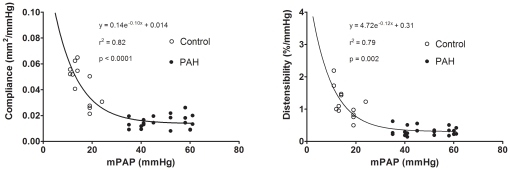
Pooled data points of control subjects (open circle) and PAH subjects (closed circle) showing the strong inverse exponential associations between compliance and mean pulmonary artery pressure (left); and between distensibility and mean pulmonary artery pressure (right).mPAP, mean pulmonary artery pressure.